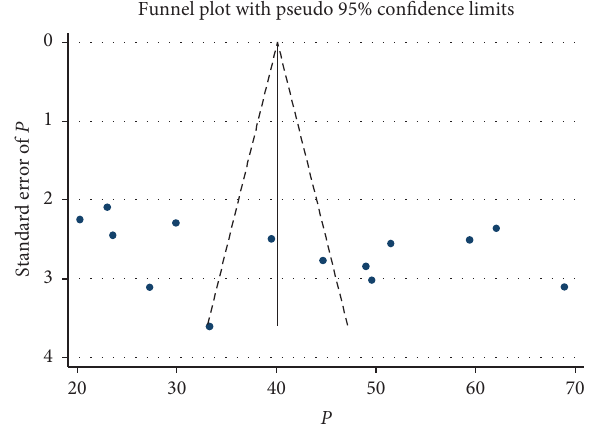
Figure 3: Funnel plot to assess the level of self-care practice among hypertensive patients in